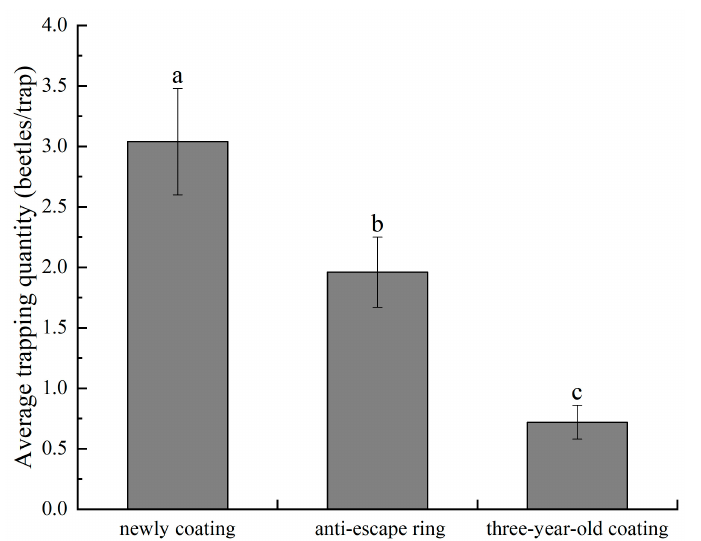
Figure 4. Effect of anti-escape ring on the trapping of Monochamus alternatus in Anji. Different letters on bar top indicate significant differences between treatments. ( α = 0.05).